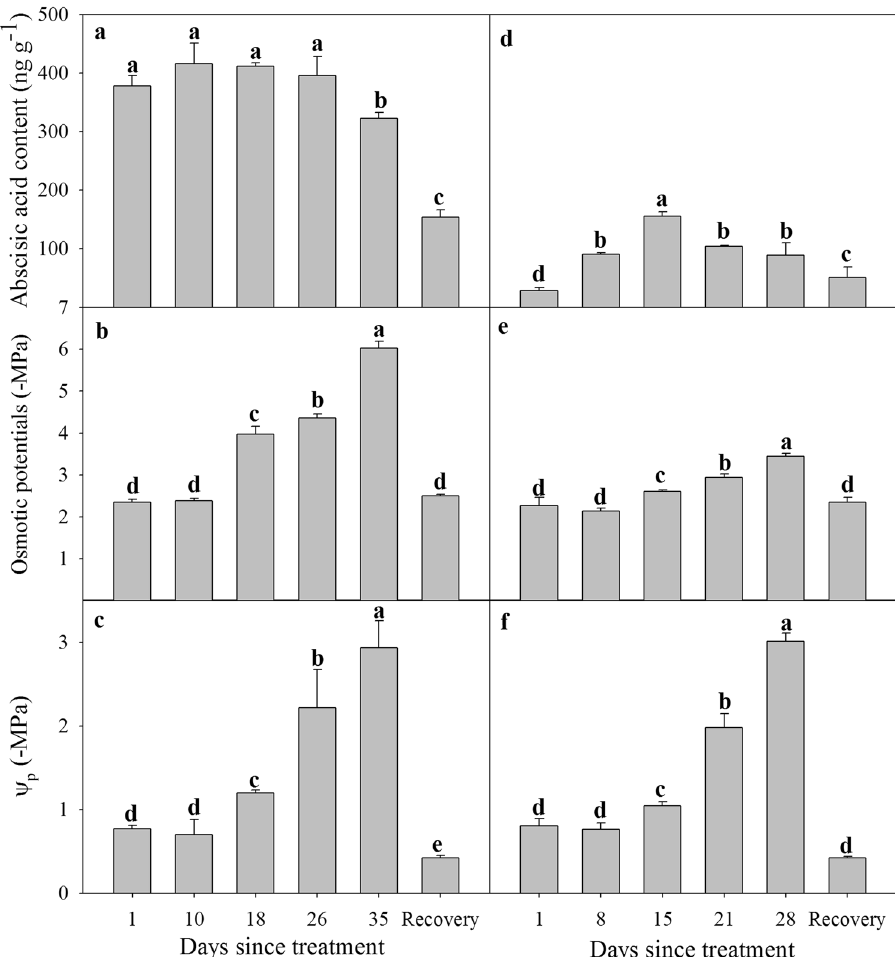
Figure 6. Abscisic acid content, osmotic potential and Ψ p on different days in the first drought cycle and after 7 days of recovery in A. fruticosa ( a , b , c ) and R. pseudoacacia ( d , e , f ). Lowercase letters indicate statistical significance at P <